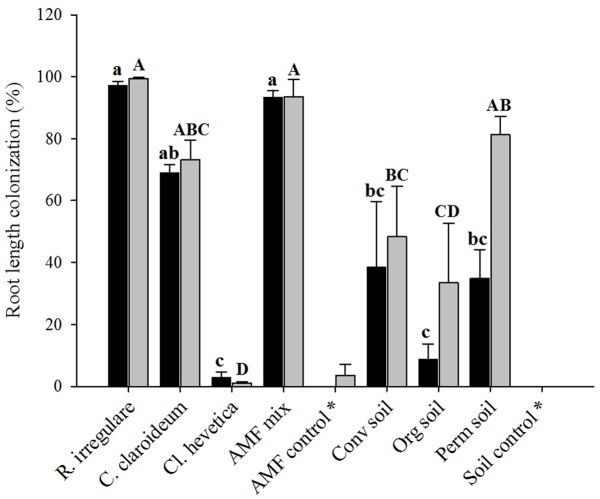
Root length colonization of naranjilla roots after 14 (black bars) and 22 (gray bars) weeks of growth as affected by inoculation with different species of AMF: Rhizoglomus irregulare, Claroideoglomus claroideum, Cetraspora helvetica, a mix of the three AMF species and an AMF control consisting of a sterilized AMF inocula mix; or local soil inoculants derived from: conventional (Conv soil), organic (Org soil), and permaculture (Perm soil) naranjilla plantations in Ecuador and a sterilized mix of the three soils as soil control. Different lower and upper case letters above bars indicate significant differences at WE 14 and WE 22, respectively (ANOVA, Tukey’s HSD test, α = 0.05). Treatments with an asterisk were excluded from statistical analysis. Data represent means + SE [n = 4 (for AMF control treatment due to exclusion of one contaminated sample), 5 (at WE 14), and 6 at (WE 22)].